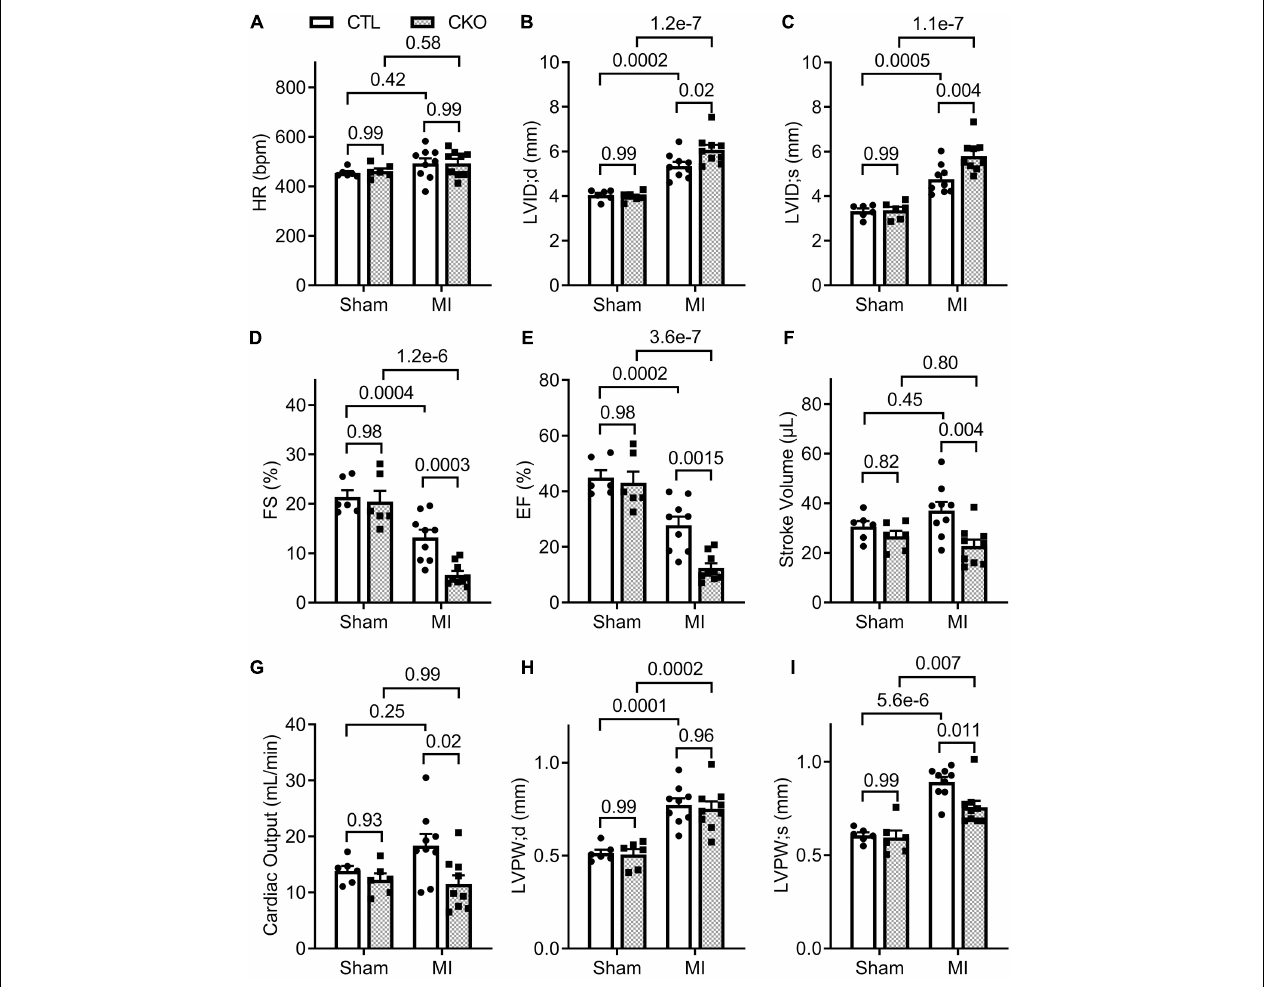
FIGURE 5 | Echocardiographic assessments 28 days post-MI. CTL and CKO mice were subjected to sham surgery or LAD ligation as described in Figure 4 . Parameters shown in panels (A–I) are derived from the B-mode guided M-model Echo performed 28 days post-MI. Each dot represents an individual mouse. For the sham groups, n = 6 mice (2 males + 4 females) for each genotype; for the MI groups, n = 9 mice (3 males + 6 females) for each genotype. The p -value of the pair-wise comparison shown above the bracket is derived from two-way ANOVA followed by Tukey’s